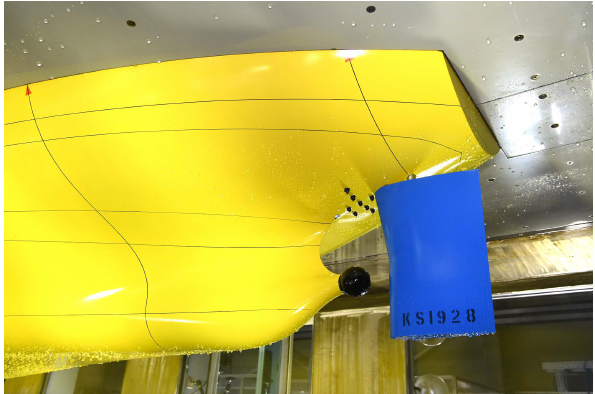
Figure 6. Setup for transfer function measurement.